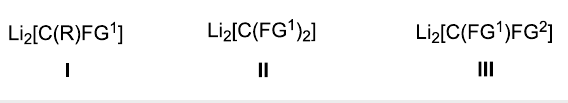
Figure 1: Functionalized dilithio methandiides (FG = functional group).